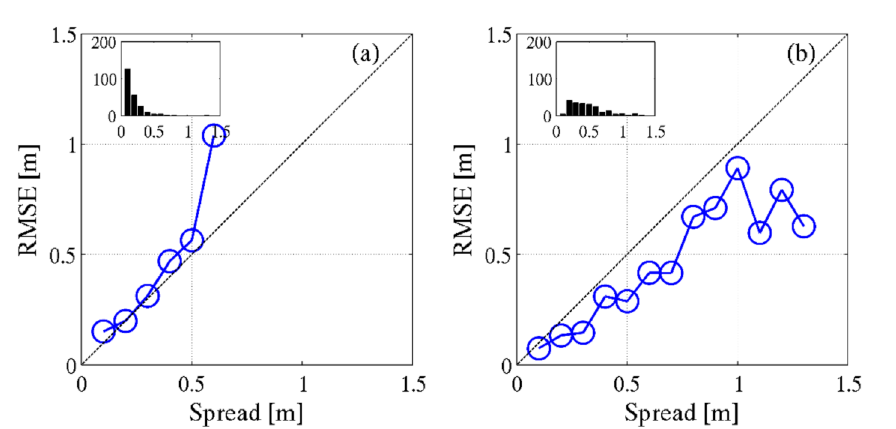
Figure 7. Spread skill relationship for significant wave height for forecast lead times of ( a ) +00 h and ( b ) +72